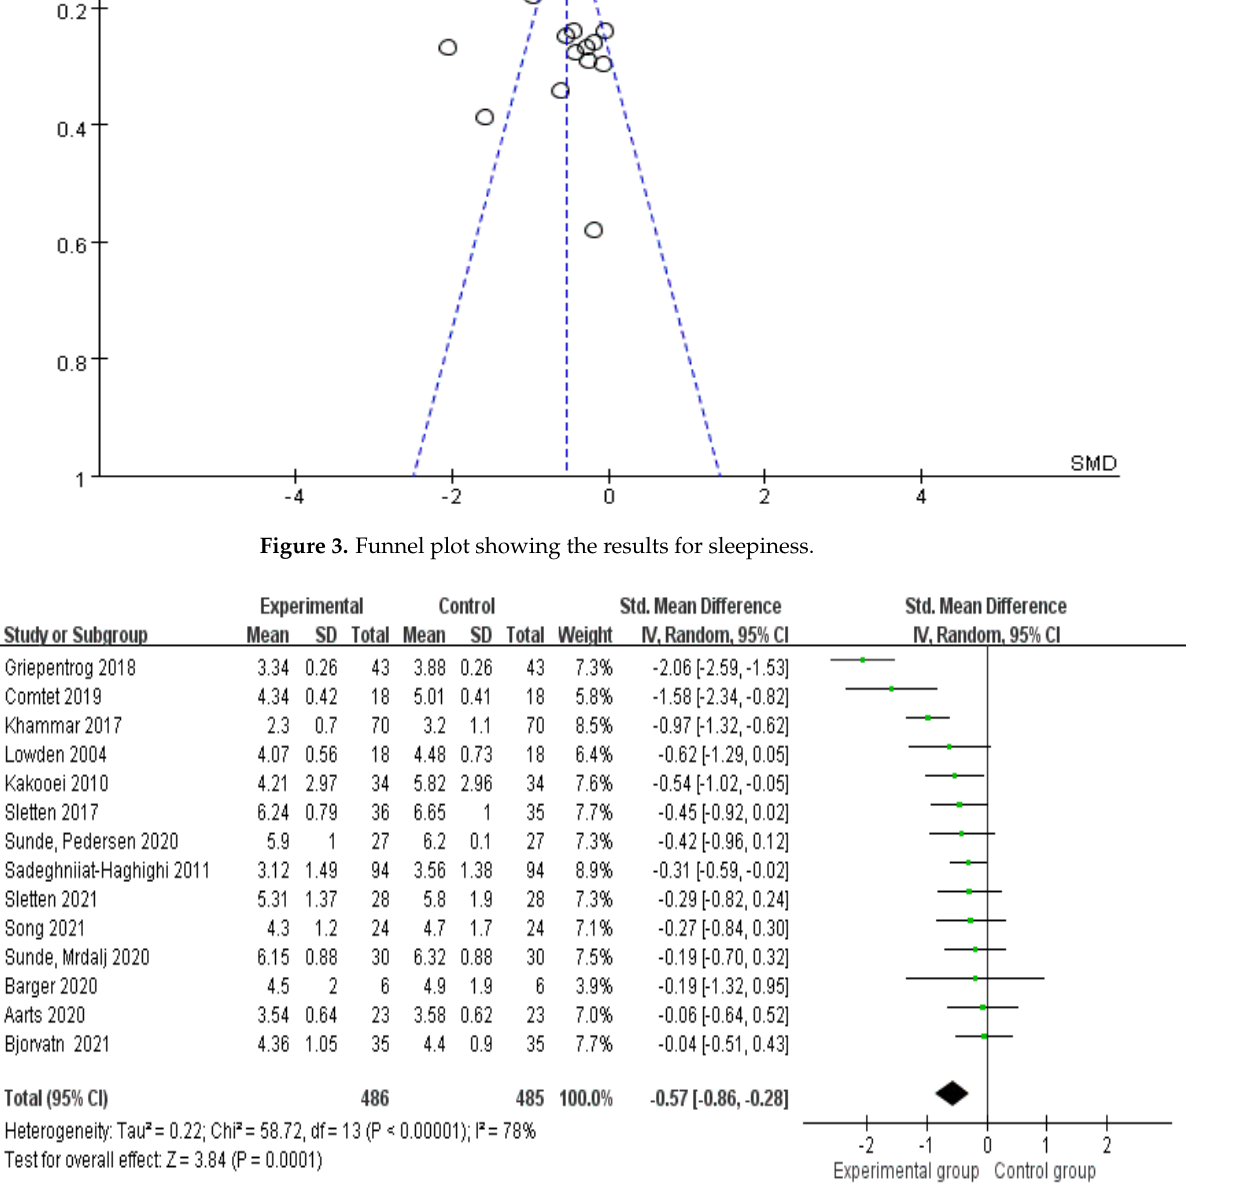
Figure 4. Forest plot of the effect of lighting interventions in improving sleepiness of night − shift workers.